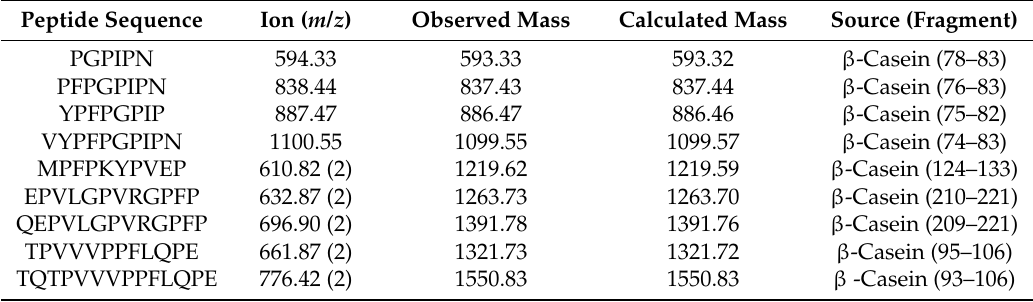
Table 3. Amino acid sequences of potent peptides in Fla-hydrolysed casein identified by LC–MS/MS and their respective protein